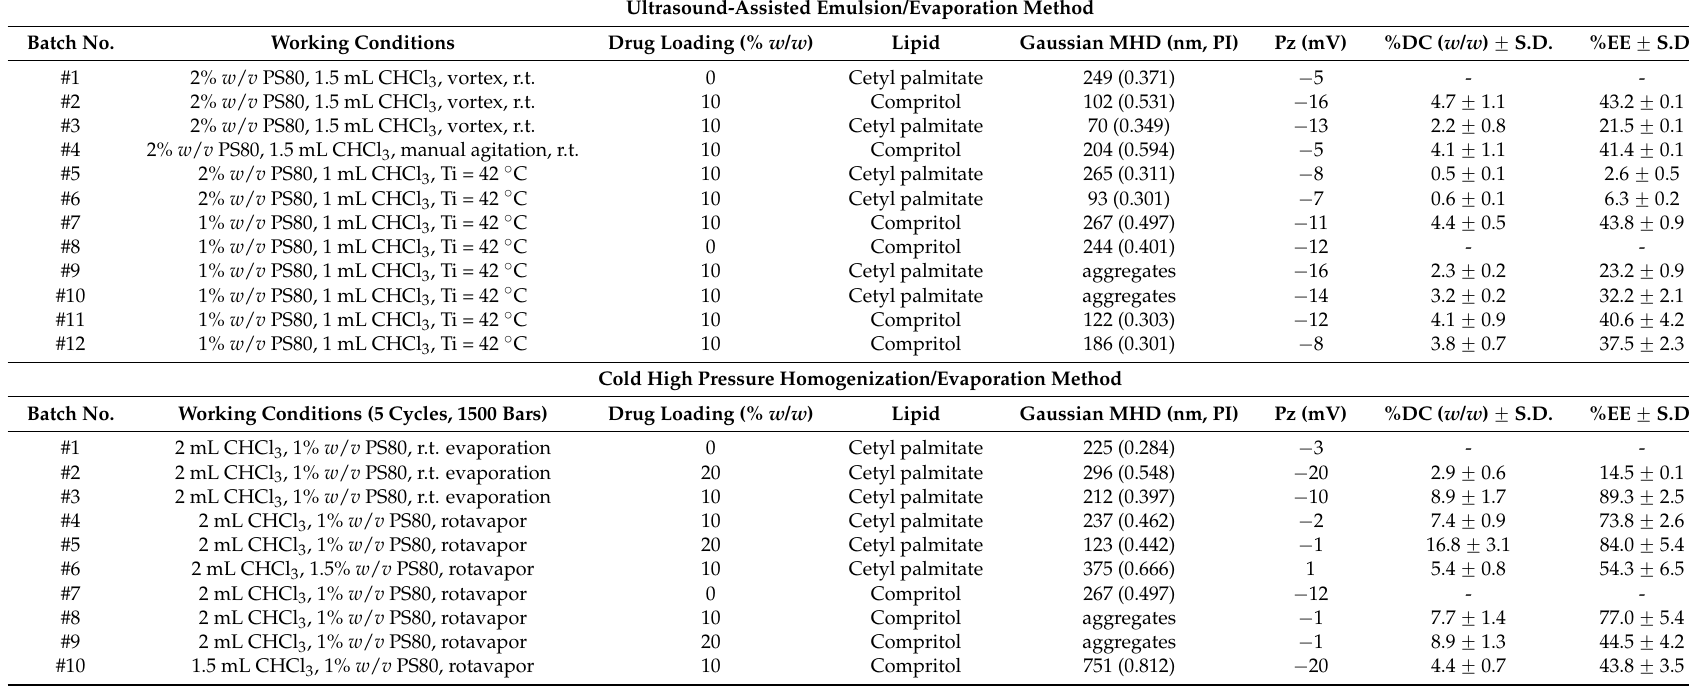
Table 1. Characterization of Rp loaded solid lipid nanoparticles (Rp-SLN) and blank SLN obtained by the Ultrasound-Assisted Emulsion/evaporation (UAEe) and the cold High Pressure Homogenization/evaporation (cHPHe)